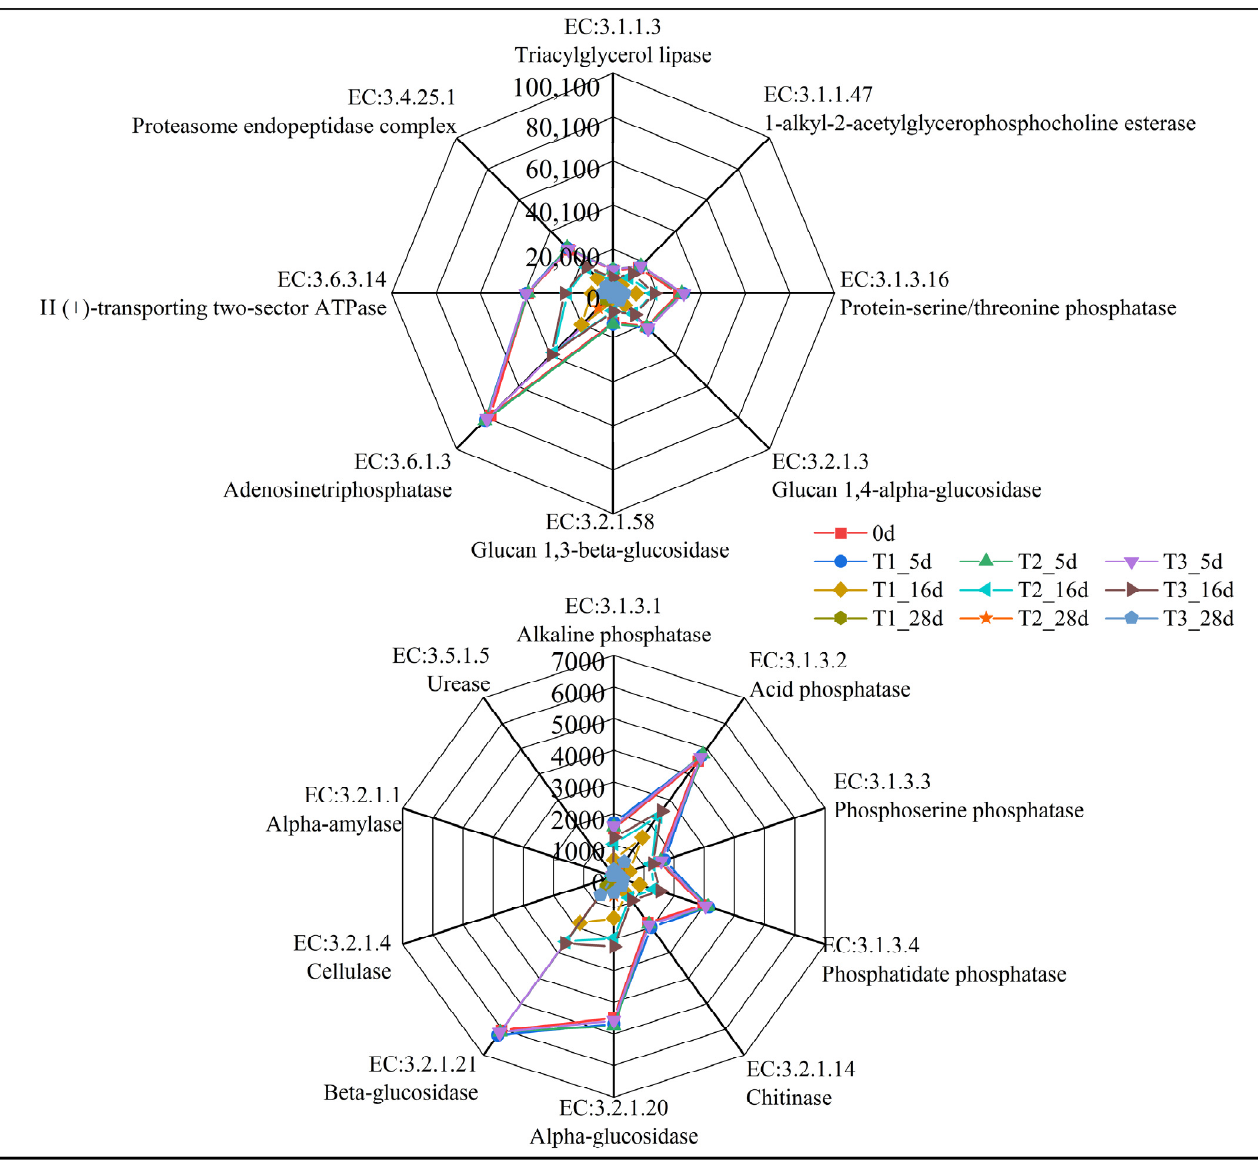
Figure 5. Prediction of fungal hydrolase gene abundance based on PICRUSt2.